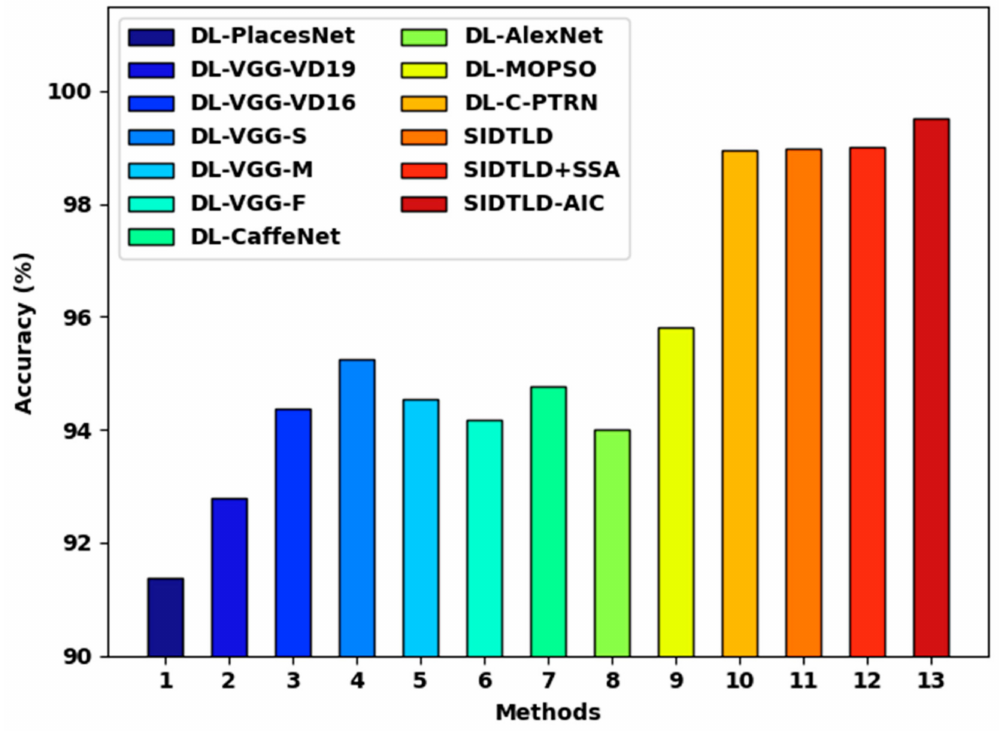
Figure 11. Accuracy analysis of SIDTLD-AIC technique with existing